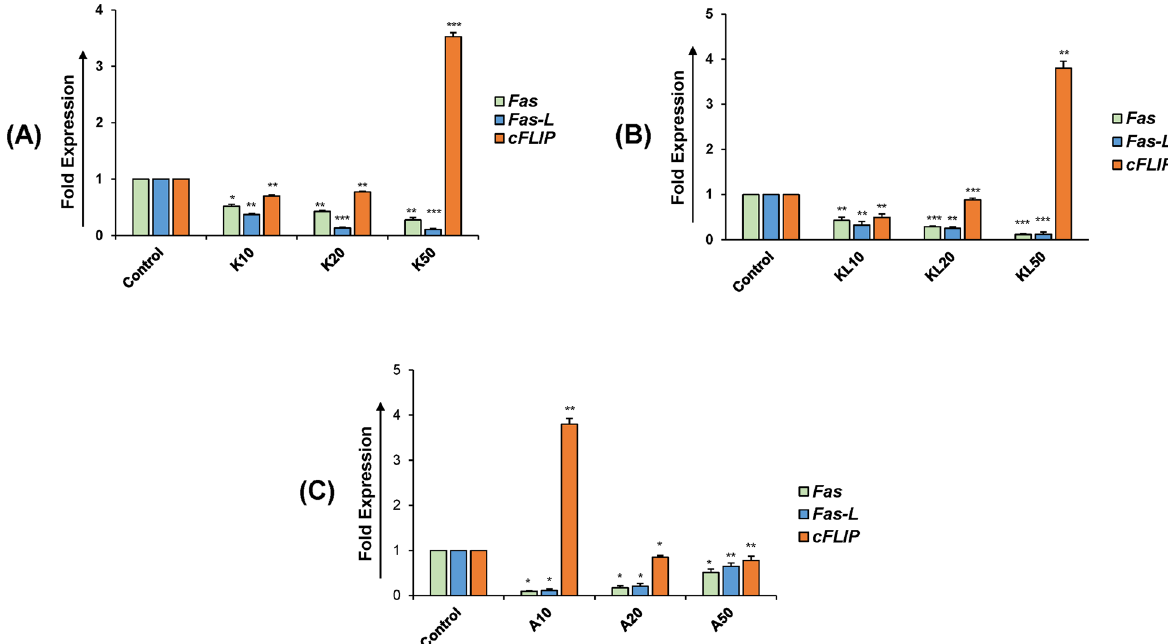
Fig. 1 The relative expression of Fas and FasL mRNA in KGF and KITLG treated granulosa cells. Expression of Fas and FasL were significantly down regulated in a dose-dependent manner by KGF and KITLG treatment and was found to be lowest at the concentration of 50 ng/ml ( A , B ). Expression of cFLIP was significantly increased and was in direct proportion to the dosage of KGF and KITLG and was found to be maximum at the concentration of 50 ng/ml. When granulosa cells were treated with both KGF and KITLG, concentration of 10 ng/ml was found to be more significant in regulation of Fas-FasL pathway by cFLIP ( C ). Data are presented as relative expression of Fas, FasL , and cFLIP mRNA/18S mRNA normalized to untreated control values. K represents the KGF, KITLG is denoted by KL and A is KGF KITLG. The dose concentrations are defined as + 10, 20, and 50 ng/ml for both KGF and KITLG. Values are expressed as the mean SD of three experiments; * P < 0.05, ** P < 0.01, *** P < 0.001 vs. the ± control